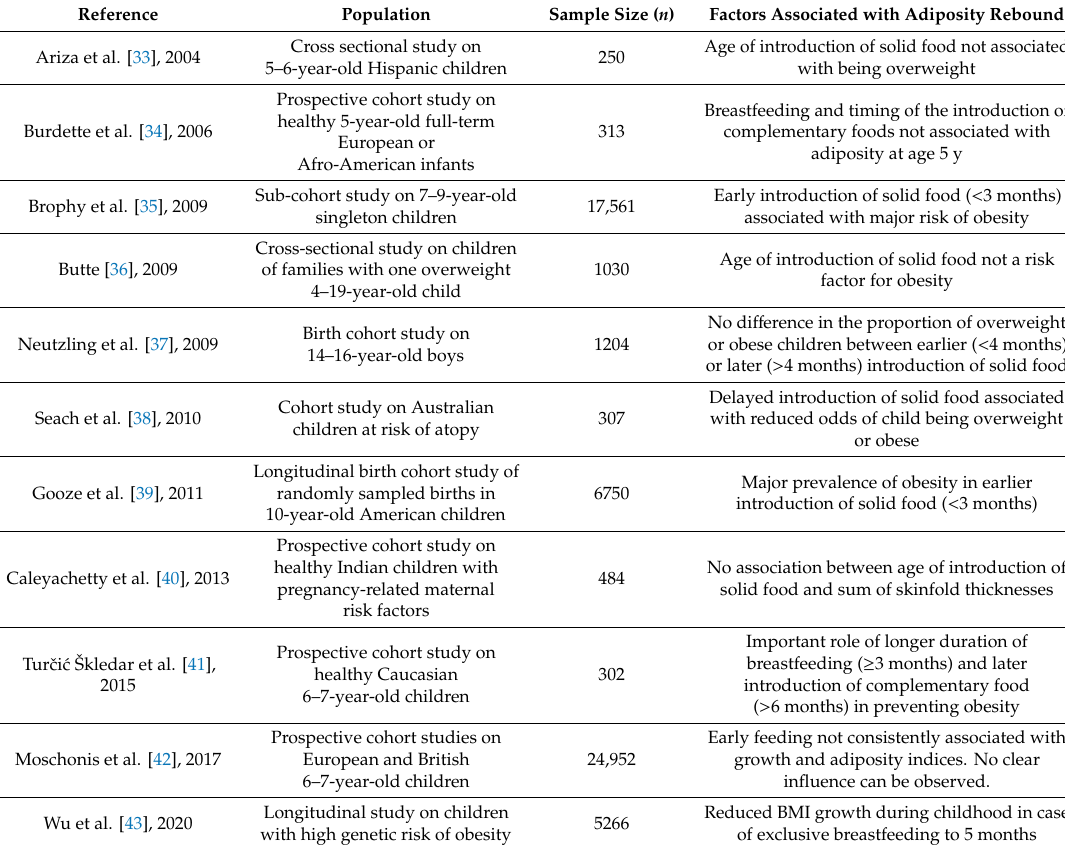
Table 6. Summary of recent studies assessing feeding factors associated with adiposity rebound in